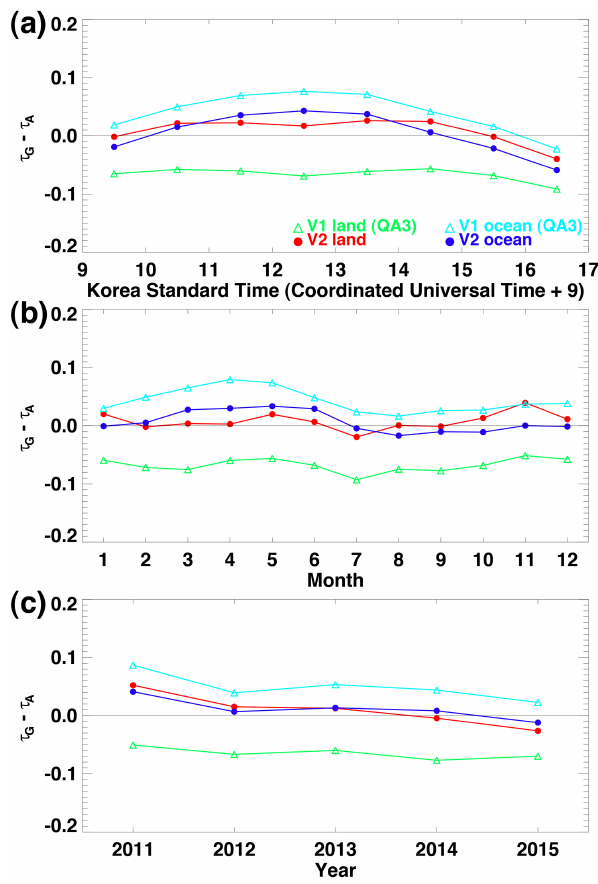
Figure 8. Difference between GOCI and AERONET AOD in terms of local observation time, month, and year. The points are as defined in Fig.